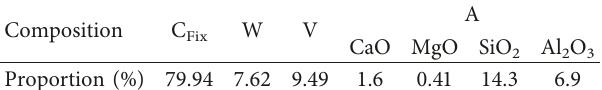
Table 2: Proximate analysis and composition analysis of coke.